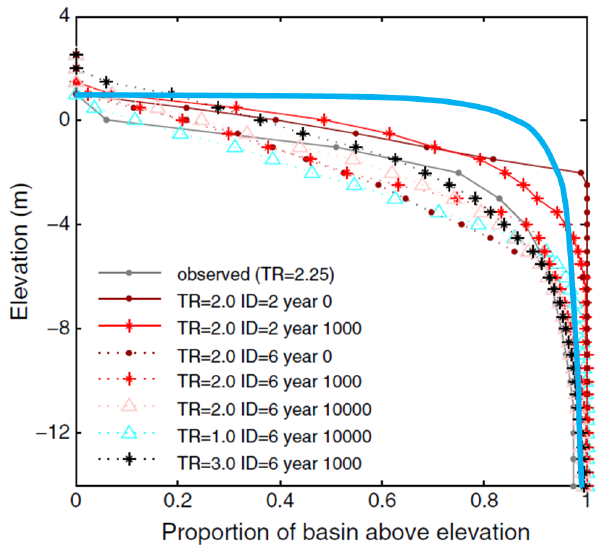
Figure A8. The blue solid line indicates the resulting basin hypsometry from the prediction for a tidal basin with dimensions based on the Ameland inlet (Figure A7) plotted in Figure 7 of van Maanen et al.